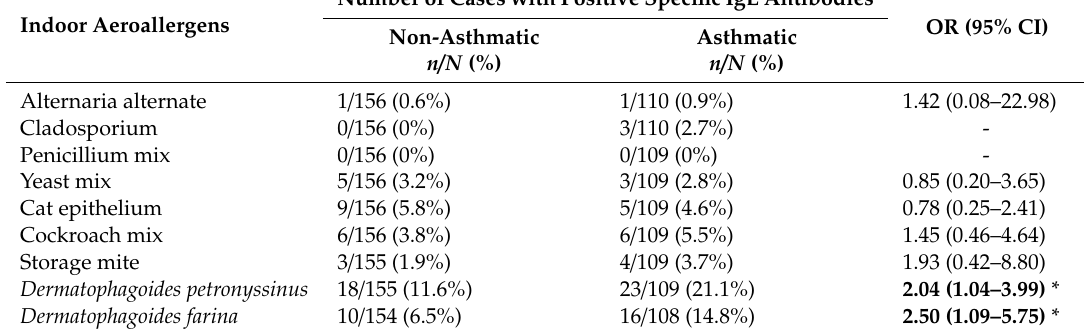
Table 4. Distribution of positive IgE antibodies specific to indoor aeroallergens among the study sample of adult